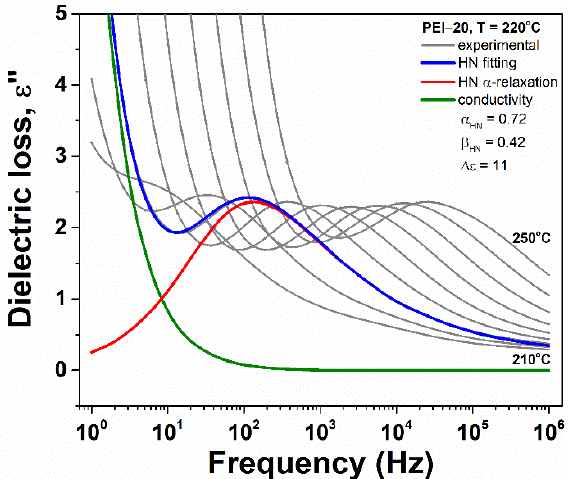
Figure 6. Exemplary frequency dependences of the dielectric loss at temperatures between 210 °C and 250 °C for the PEI-20 nanocomposite. A representative separation of the segmental α in terms of the HN fit function is provided at 220 °C. The corresponding fitting parameters are presented in the box.